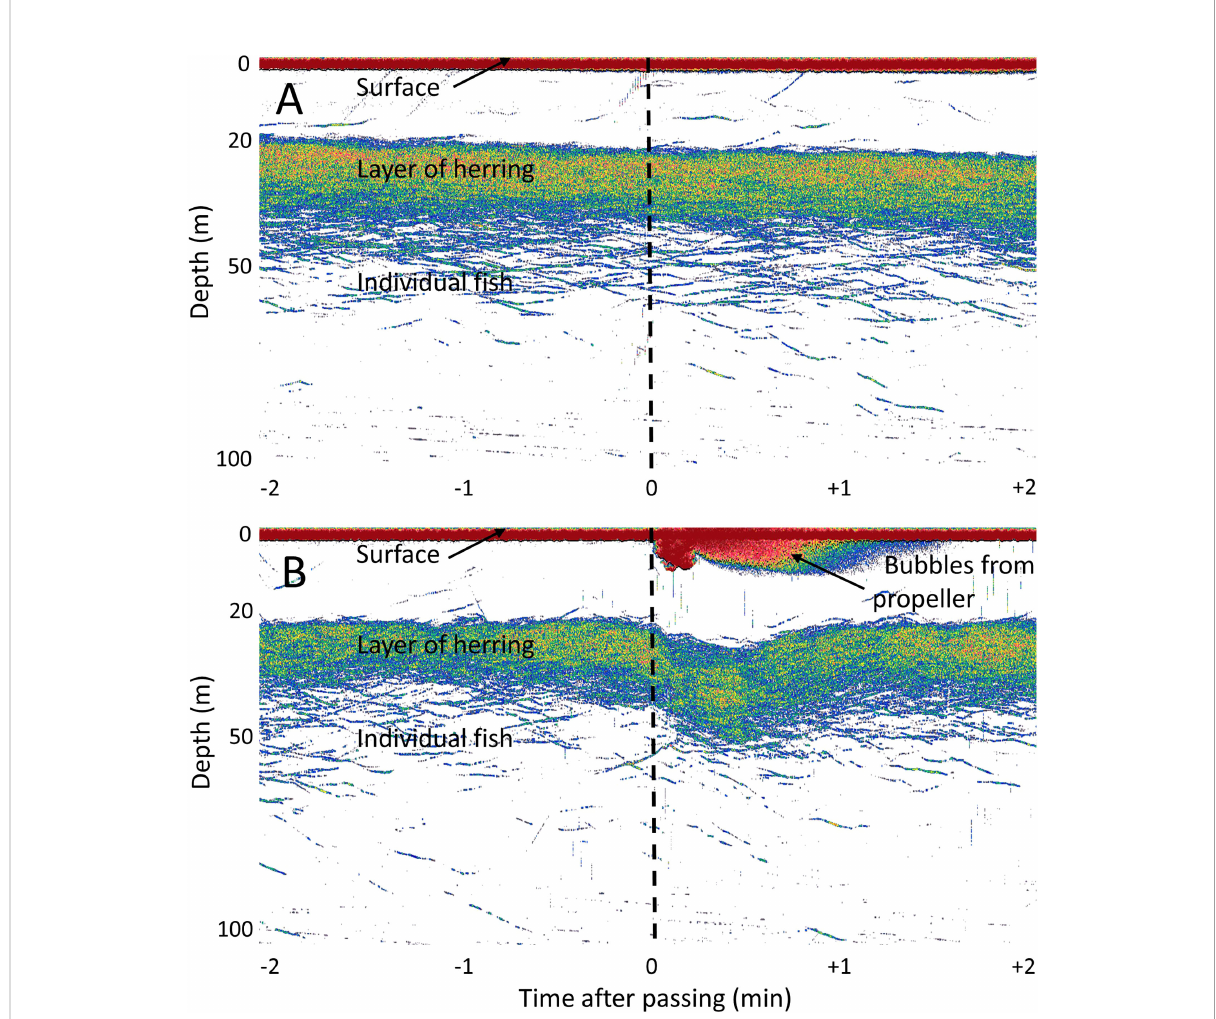
FIGURE 7 Echograms from an upward looking echo sounder mooring when the Kayak Drone (A) and a research vessel (B) pass over the mooring. A dense layer of herring can be observed from 20 to 40 meters below the surface. Below the herring layer, dispersed individual fi sh can be seen. Air bubbles from the propeller of the vessel (B) can be seen down to approx. 10 meters depth, while no bubbles are produced by the Kayak Drone (A) . The time of passing the mooring is shown as vertical black